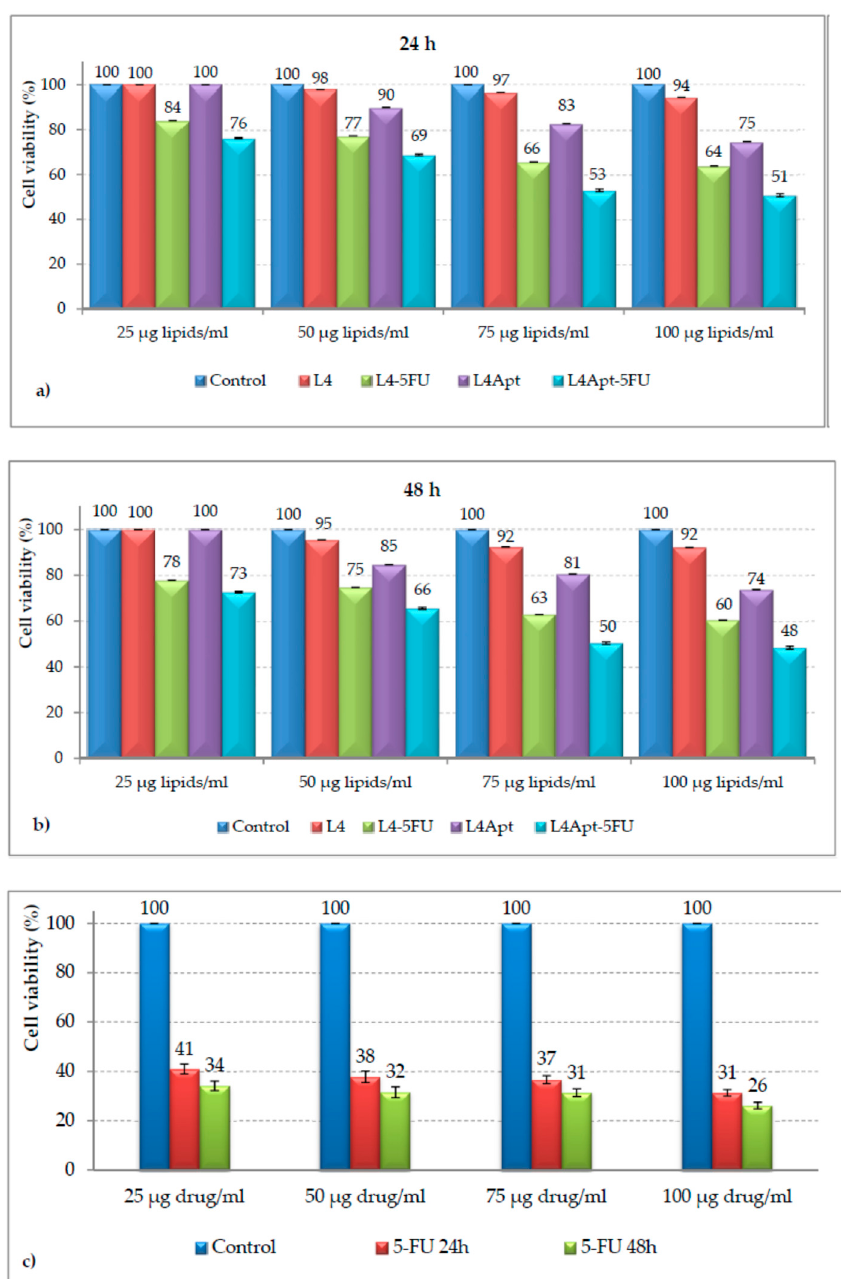
Figure 4. The cell viabilities of TE 354.T with L4, L4-5FU-15, L4Apt, L4Apt-5FU-15 with 25, 50, 75, and 100 µ g lipids/mL doses for ( a ): 24 h and ( b ): 48 h and ( c ): 5-FU with 25, 50, 75, and 100 µ g drug/mL doses for 24 and 48 h [106].